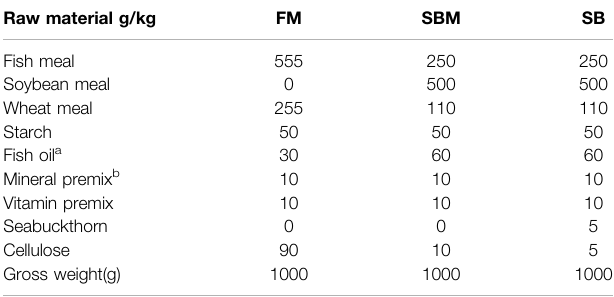
TABLE 1 | Formulation of experimental